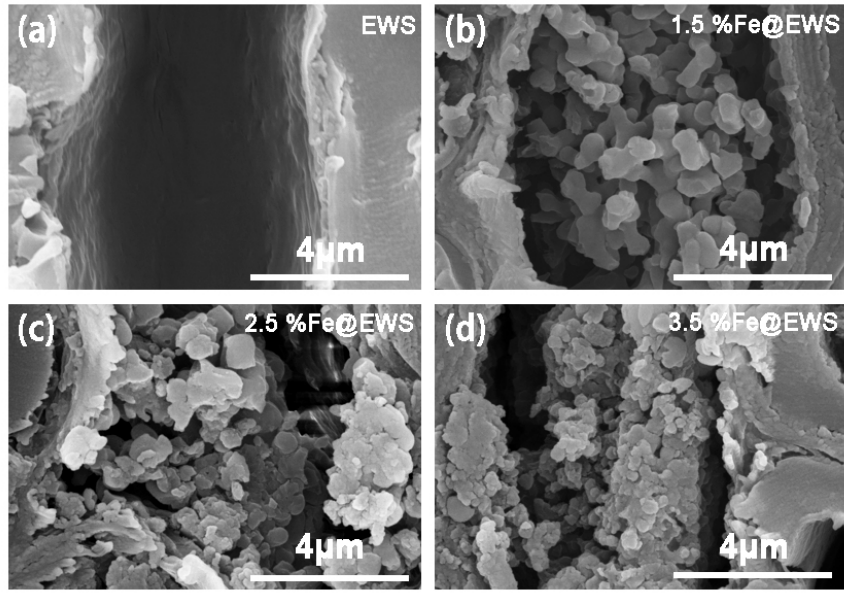
Figure 3. Cross-section SEM images of EWS ( a ), 1.5%Fe@EWS ( b ), 2.5%Fe@EWS ( c ), and 3.5%Fe@EWS ( d ).